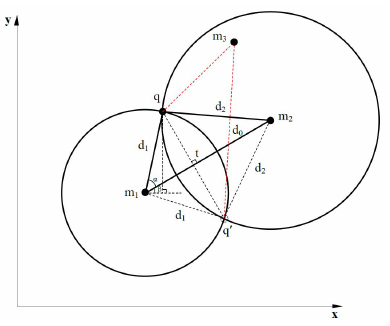
Figure 5. Position candidate